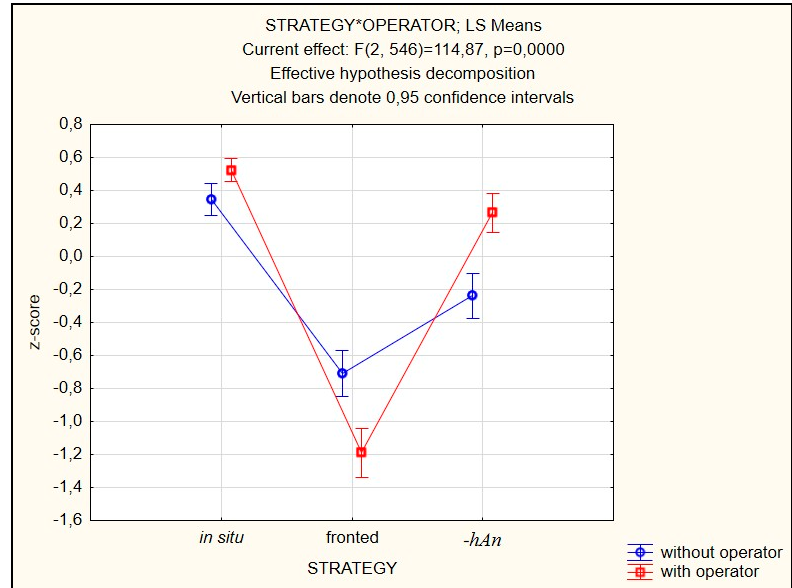
Figure 11. Strategy*Operator interaction (Finnish).